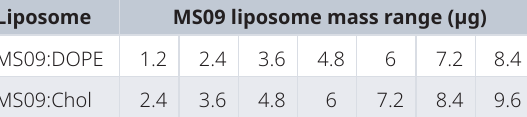
Table 2. Varying amounts of MS09 liposomal formulations used in the gel retardation